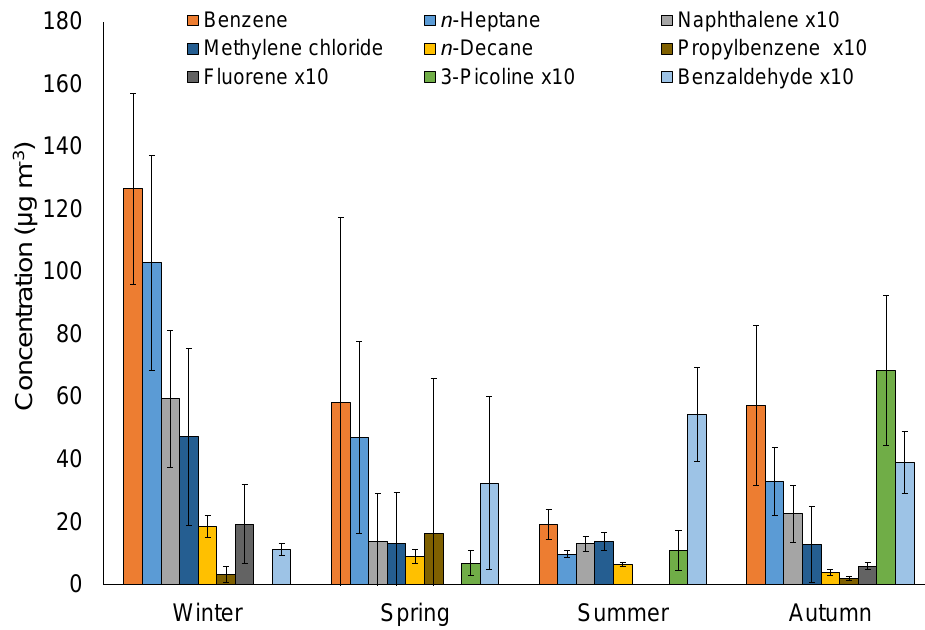
Figure 2. Seasonal concentrations (mean of the sampling days in each season ± SD) of the VOCs. The seasonal variations of toluene, 1,2-dichloroethane, ethylbenzene, m -, p -, o - xylenes, propylbenzene, chlorobenzene, 1,3,5-trimethylbenzene, 1,2,4-trimethylbenzene, and phenol were insignificant and varied from 0.070 to 61 µg m −3 (Figure S1 in